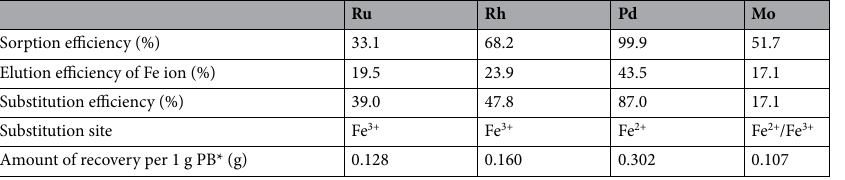
Table 1. The sorption efficiency of PGMs/Mo ions into PBNPs, the elution efficiency of Fe ion from PBNPs after 24 h sorption test, the substitution efficiency of PGMs/Mo with Fe 2+ or Fe 3+ ion, the substitution site, and the amount of recovery per 1 g PB. *Chemical form: KFe(III)[Fe(II)(CN)6]. Sorption efficiency [%] = [( C initial − C final)/ C initial] × 100. Here, C initial and C final denote the concentration of Pd ion in nitric acid solution before and after 24-h sorption test,